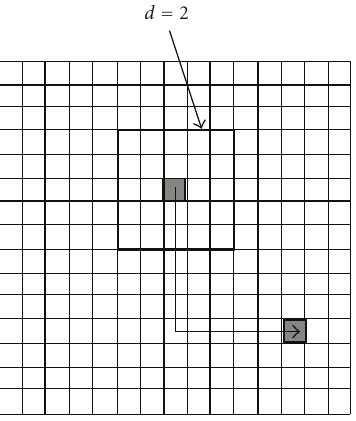
Figure 2: Routes between cells are along at most two straight lines.